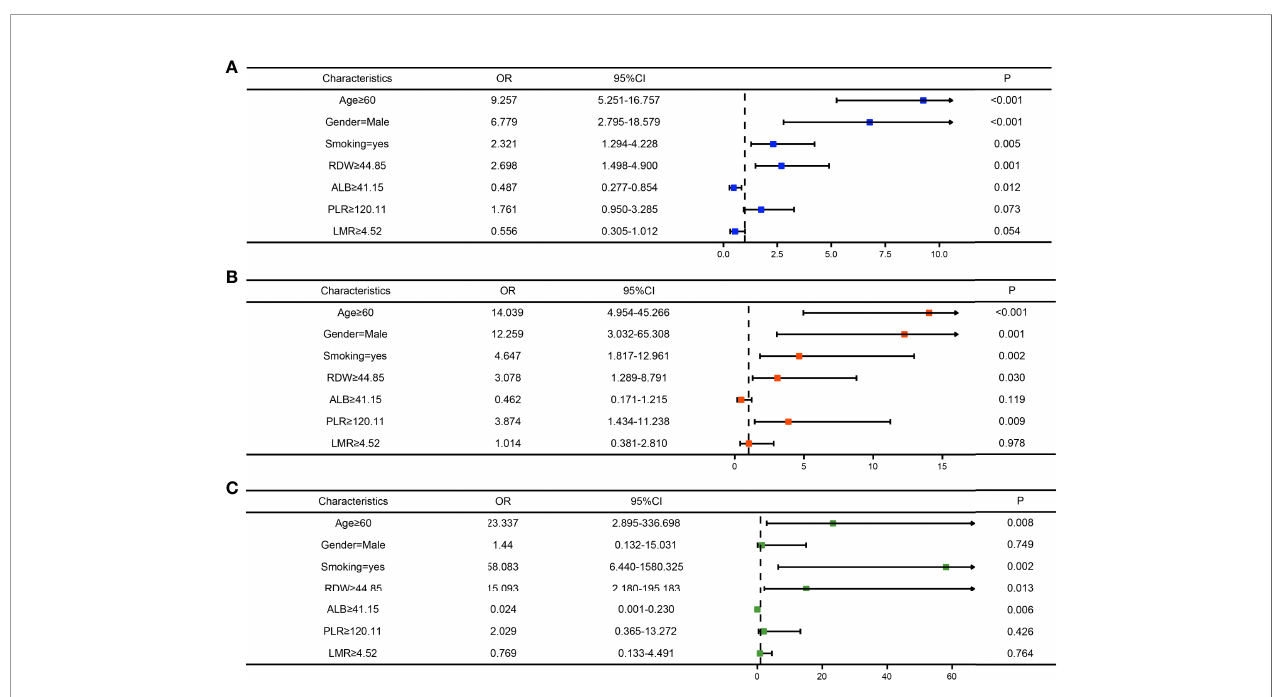
FIGURE 4 | Forest maps of the logistic regression analysis of the training cohort (A) , internal test cohort (B) , and, external test cohort (C)